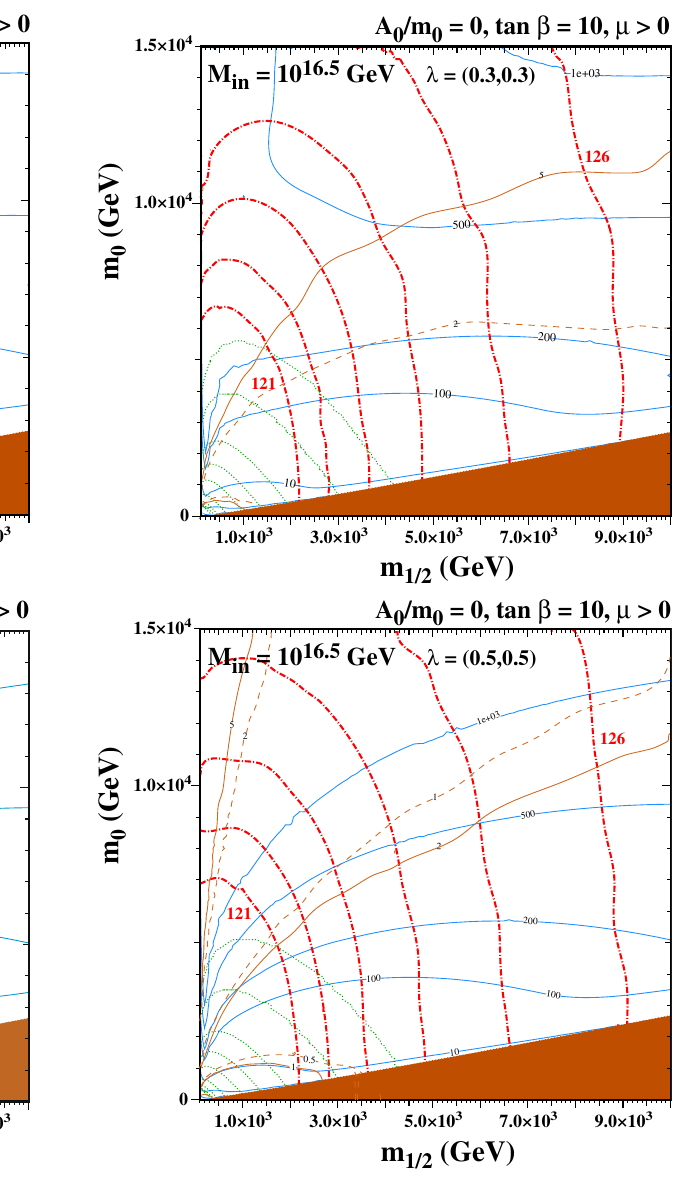
Fig. 4 Representative ( m 1 / 2 , m 0 ) planes in the FSU(5) GUT model. The fixed parameters as the same as in Fig. 1, except for λ = (0.1,0.3) in the top left panel, λ = (0.3,0.3) (top right), λ = (0.3,0.5) (bottom left),